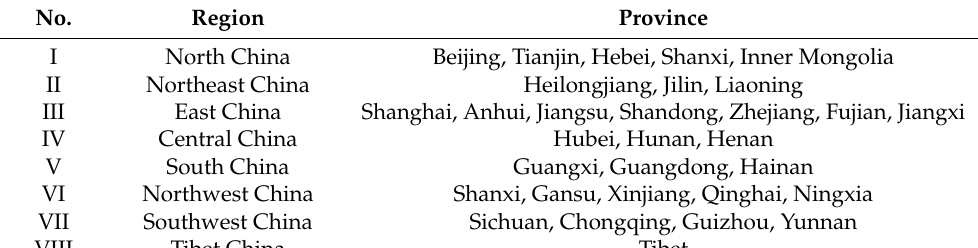
11 of 17 Figure 7. Monthly mean 24 h error variation: ( a ) RMSE for background; ( b ) RMSE for analysis. 3.4. Evaluation in Different Climatic Regions Based on comprehensive consideration of the province division and climatic zone